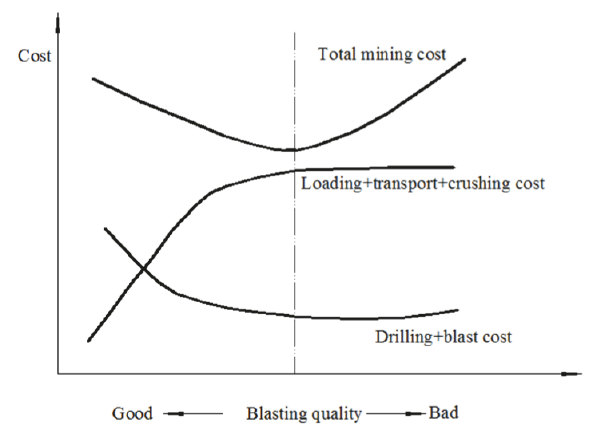
Figure 18: Curves of the resistance line, blasting volume, and bulk yield (hole spacing a =8.5